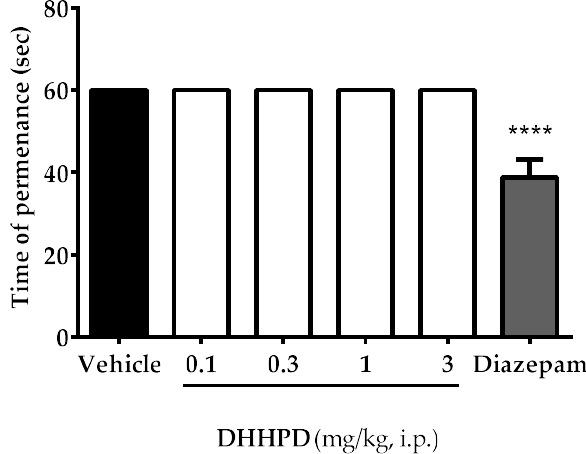
Figure 6. Effect of DHHPD on the rotarod test in mice. Each column denotes the mean ± SEM ( n = 6). The asterisks (*) represent the significance level as compared to the vehicle group, **** p < 0.0001 by one-way ANOVA followed by Dunnett’s post hoc test. Mice were pre-treated with vehicle (10 mL/kg, i.p.), diazepam (4 mg/kg, i.p.) and DHHPD (0.1, 0.3, 1 and 3 mg/kg, i.p.).